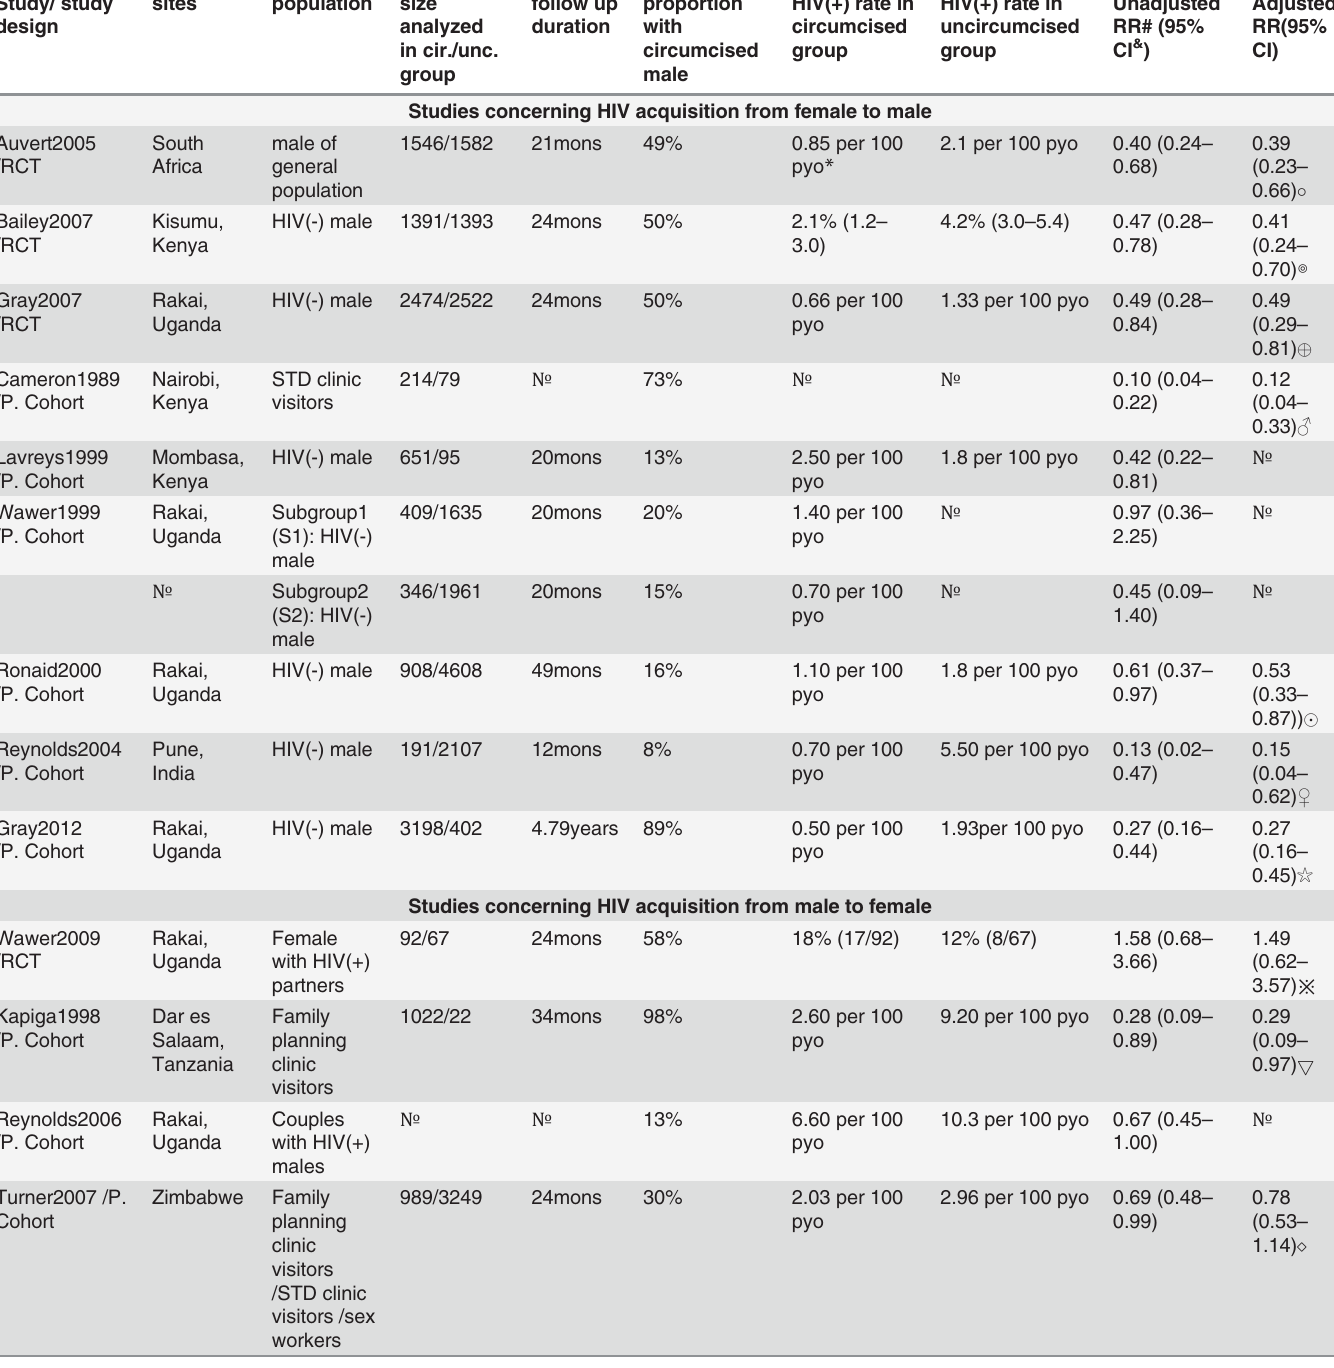
Table 1. Summary table of correlation of male circumcision status and HIV